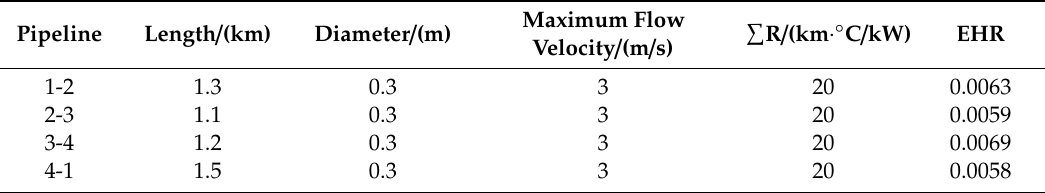
Table 3. Parameters of the heating network.